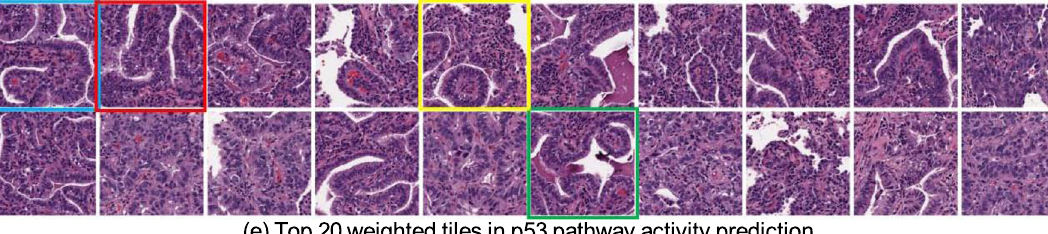
Fig. 5 Weight maps of tiles when predicting the point mutation status of TP53 and p53 pathway activity from mRNA expression data in lung cancer. a Tumor tiles after data processing. b Weight map of tumor tiles in TP53 point mutation prediction. Brighter green tiles have larger weights. c Weight map in p53 pathway activity prediction. d, e Top 20 weighted tiles for the TP53 point mutation prediction and p53 pathway prediction, respectively. We marked four tiles that appeared in both tasks. These tissues contain moderately differentiated lung carcinoma with papillary growth pattern from a pathologist ’ s